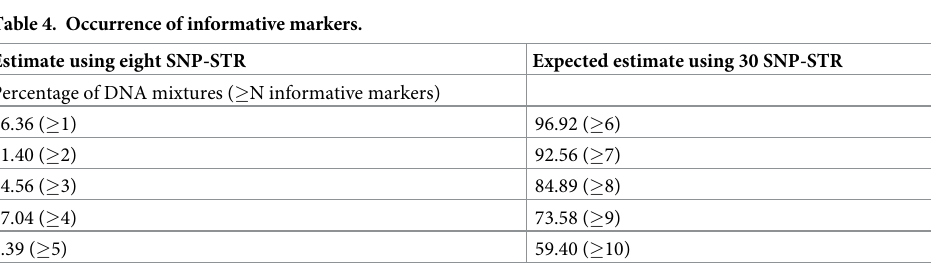
Table 4. Occurrence of informative